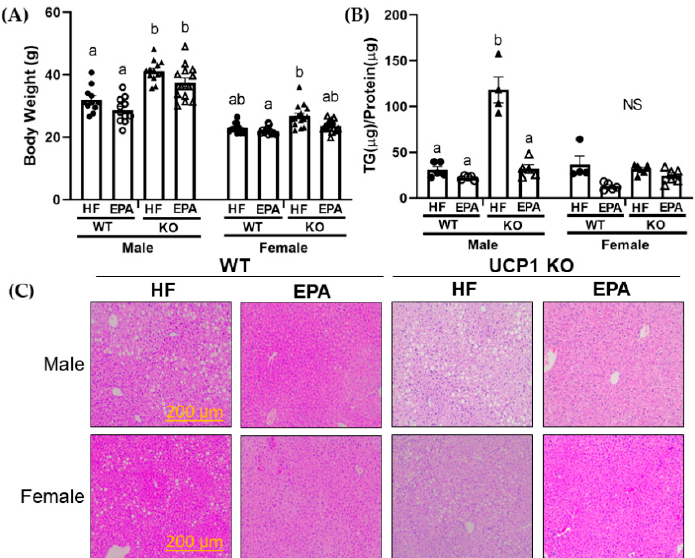
Figure 1. EPA reduces hepatic triglycerides (TG) in UCP1 KO males independent of body weight. ( A ) Final body weights of male and female wild type (WT) and UCP1 knockout (KO) mice. UCP1 KO significantly increased body weight in males but had no impact in female mice. There was no significant impact of EPA on body weight in either WT or KO male or female mice groups.